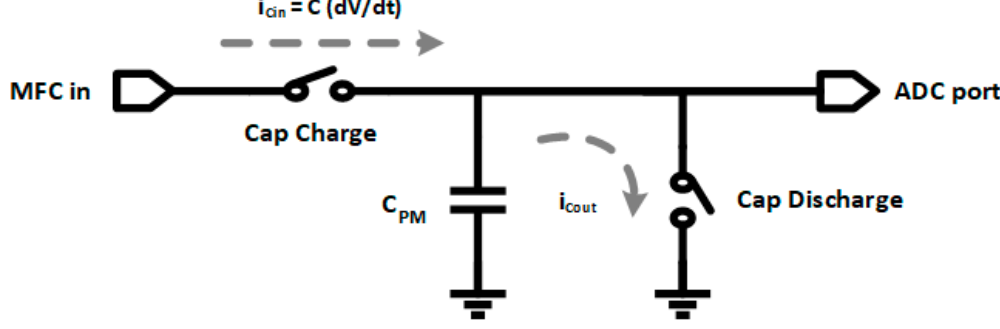
Figure 4. Diagram of the proposed power measurement circuit.